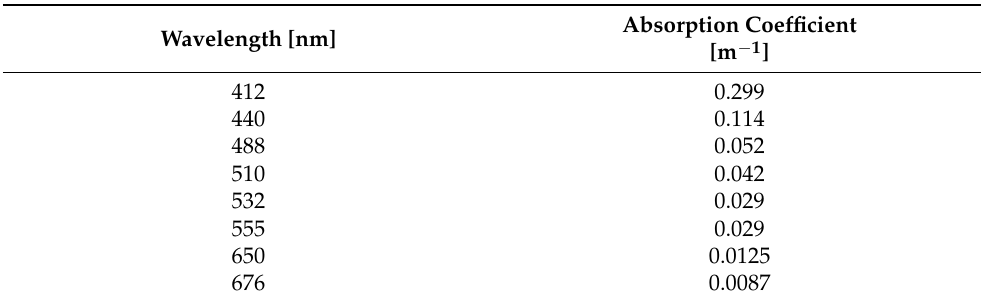
Table 3. The absorption coefficient of an oil-in-water emulsion with a concentration of 10 ppm used in the sea environment optical model [26].